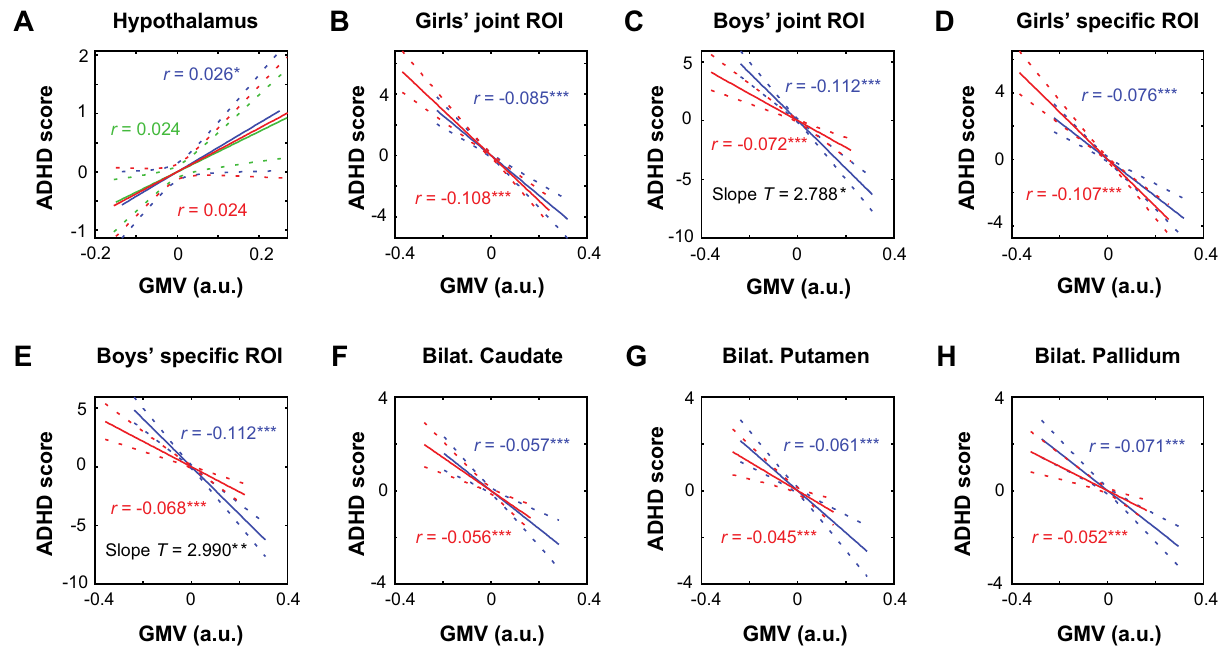
Figure 2. Linear correlations between ADHD scores and GMVs for ( A ) hypothalamus, ( B ) girls’ joint ROIs, ( C ) boys’ joint ROIs, ( D ) girls’ specific ROIs, ( E ) boys’ specific ROIs, ( F ) bilateral caudate, ( G ) bilateral putamen, and ( H ) bilateral pallidum, plotted separately for girls (in red) and boys (in blue), with age, race, twin status, study site, scanner model, and TIV as covariates. Linear correlation for girls and boys combined is also shown for hypothalamus (in green). Only boys’ joint and specific joint ROIs showed GMVs in negative correlation with ADHD score more significantly in boys than in girls ( p’s < 0.05/8 = 0.00625). Note that the residual scores after controlling for covariates are shown here. Dashed lines represent 95% confidence intervals of the mean regressions (solid lines). a.u. = arbitrary unit of GMV estimates; Bilat. = Bilateral. *** p < 0.001, ** p < 0.005, and *p < 0.05. See Supplementary Table S3 for